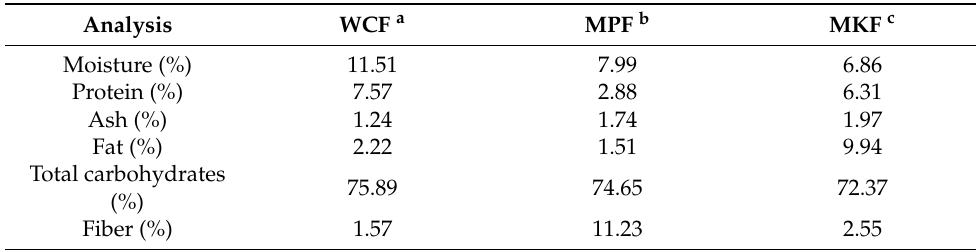
Table 2. Bromatological analysis of mango peel and kernel